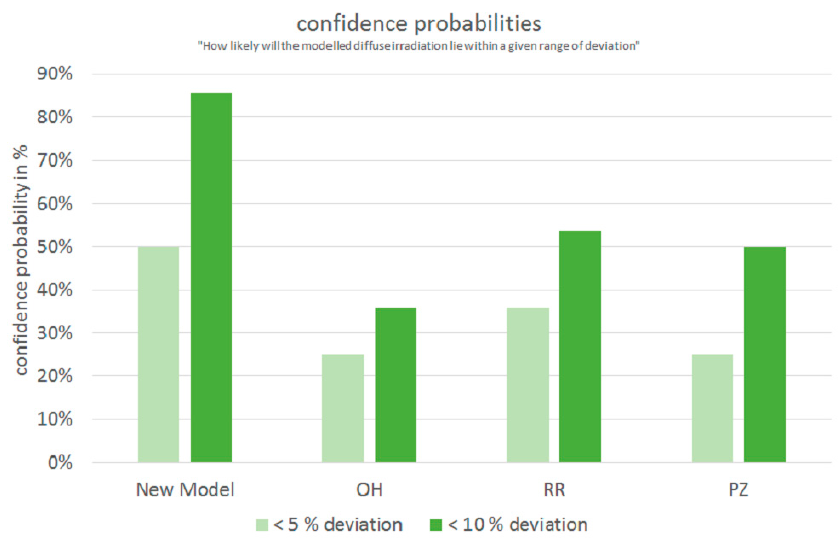
Figure 15. Histogram of the mean absolute deviations of the annual diffuse irradiation in classes of 5%. Most of the deviations produced by the new model are smaller than 10% (compare Figure 16). In none of the test cases deviations of more than 20% can be observed. While the model by Reindl et al. [3] (RR, orange) has most of its test cases in classes <15%, it still produces in some cases results of more than 40%. The model of Orgill and Hollands [18] (OH, grey) features less extreme deviations but shows a strong frequency of deviations between 10% and 20%. The model by Perez and Ineichen [23] (PZ, yellow) does not produce outliers and has its results distributed evenly between 0 and 15%.